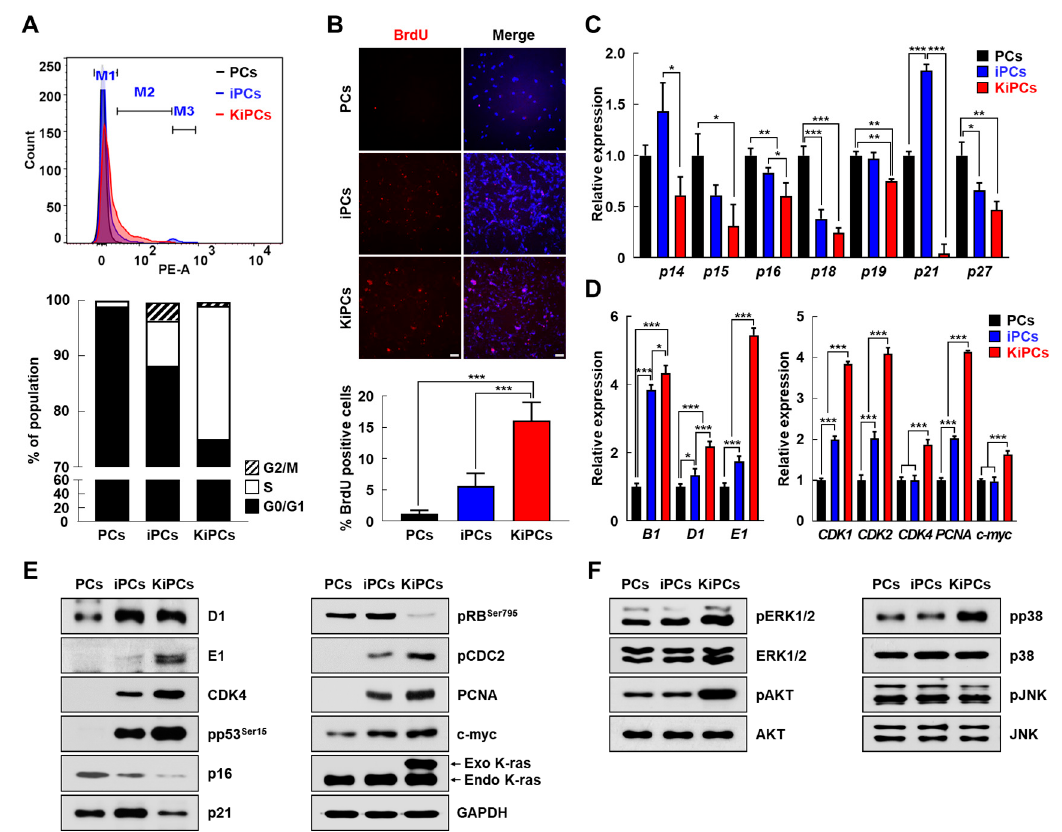
Figure 3. KiPCs exhibited altered levels of cell cycle-regulated genes and mitogen-activated protein kinase (MAPK) kinase pathway members. ( A ) The cell cycle was analyzed by fluorescence-associated cell sorting after DNA staining with propidium iodide. M1: G0/G1, M2: S, and M3: G2/M phase. Percentages of cells in each cell cycle phase are shown in the bar graph. ( B ) Representative images of Bromodeoxyuridine (BrdU) staining (top) and percentages of BrdU-positive cells in the indicated groups (bottom). Magnification 100×. ( C ) qPCR analysis of cyclin-dependent kinase inhibitors. ( D ) qPCR analysis of cyclins and cyclin-dependent kinase-associated genes. ( E ) Cell cycle-related proteins and proliferation markers were measured by Western blot analysis. ( F ) Activation of three MAPKs was measured by Western blot analysis using phosphorylated protein-specific antibodies. Magnification 100 × . All experiments were performed using at least three replicates, and the results are representative of three independent experiments. Data are presented as means ± standard deviation. * p < 0.05, ** p < 0.01, *** p < 0.001, one-way analysis of variance with Holm–Sidak multiple comparisons.